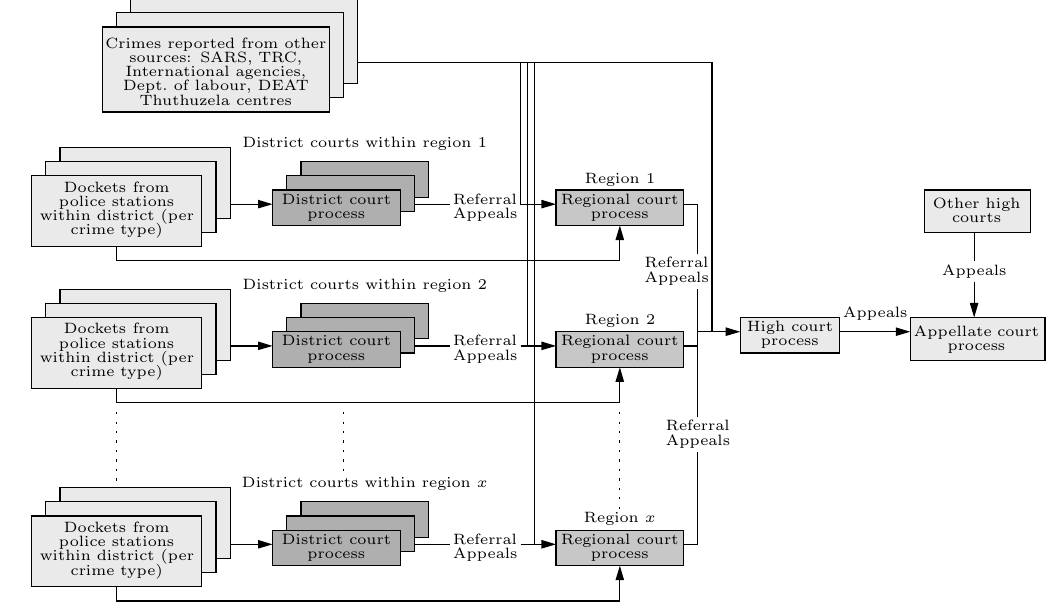
Figure 3: Initial high level conceptual model which had to be